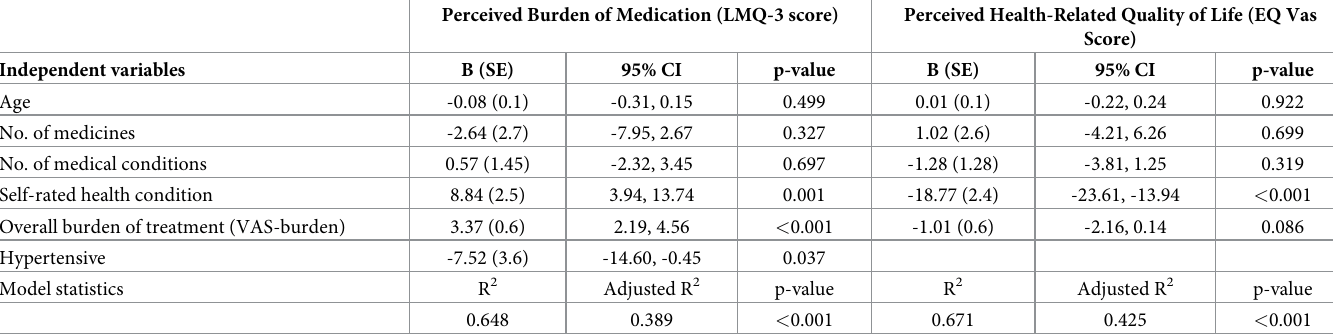
Table 4. Regression models showing factors associated with perceived burden of medication and perceived health-related quality of